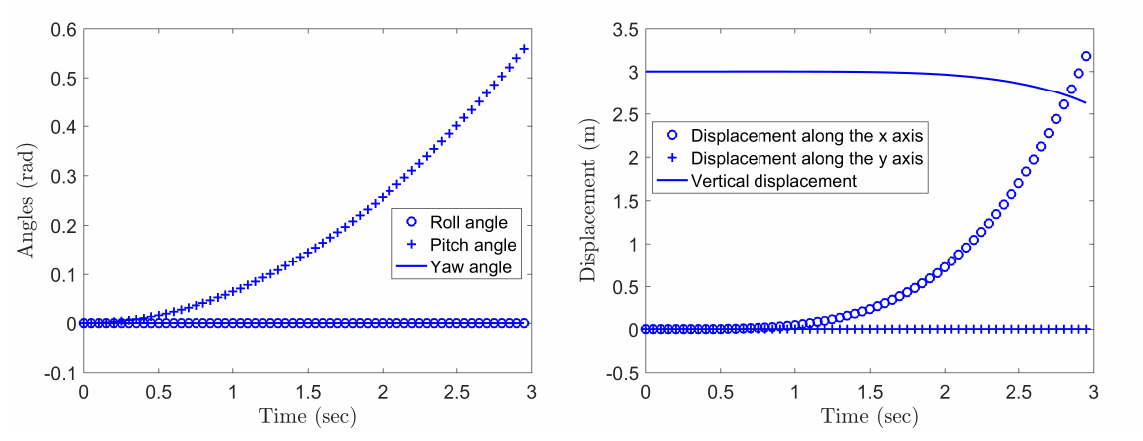
Figure 8. Trajectory of a quadrotor drone in Experiment 3.